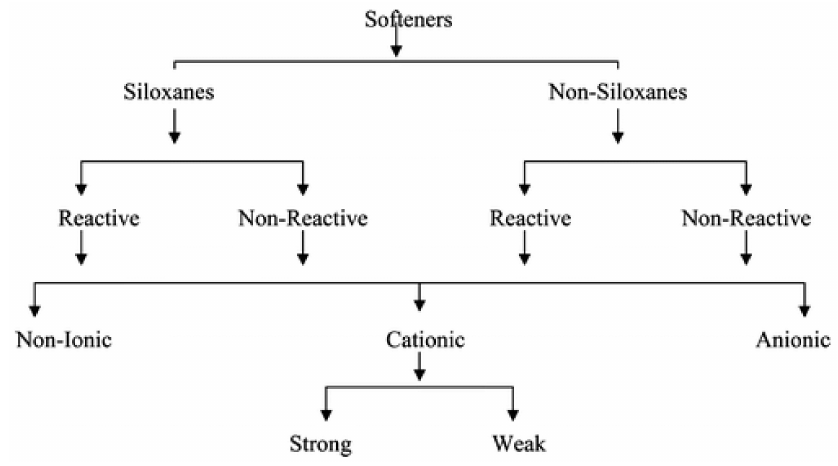
Figure 1. General classification of softeners [9]. Adapted with permission—Copyright American Chemical Society